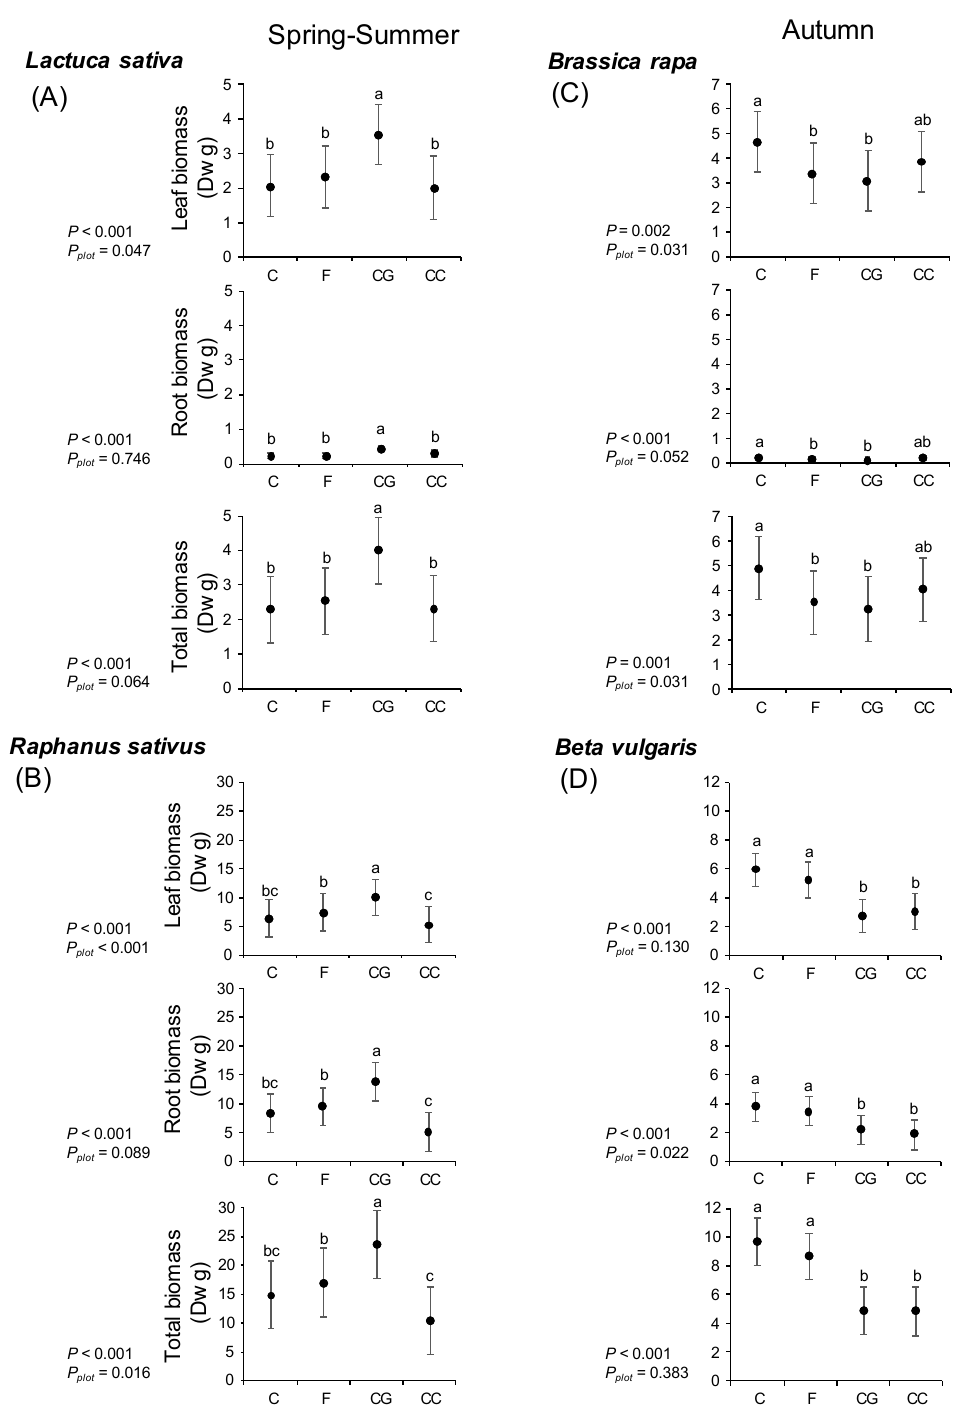
Figure 4. Effect of waste treatments on leaf, root, and total biomass of Lactuca sativa ( A ) and Raphanus sativus ( B ) grown in field plots in Spring–Summer (Experiment 3, 2020) and of leaf, root, and total biomass of Brassica rapa ( C ) and Beta vulgaris ( D ) grown in field plots during Autumn (Experiment 4, 2020). Upper figures = leaf-edible crops. Lower figures = bulb-edible crops. C = control, F = Vicia faba pod waste, CG = spent coffee grounds waste, CC = corn cobs waste. Dw = dry weight. plot = random factor. Figures show least-square mean values (± confidence intervals). n = 4–12, 10–15, 9–11, and 10–14 for L. sativa, R. sativus , B. rapa , and B. vulgaris , respectively. Different letters indicate statistical differences according to the lsmeans function at p ≤ 0.05 after conducting linear mixed models.